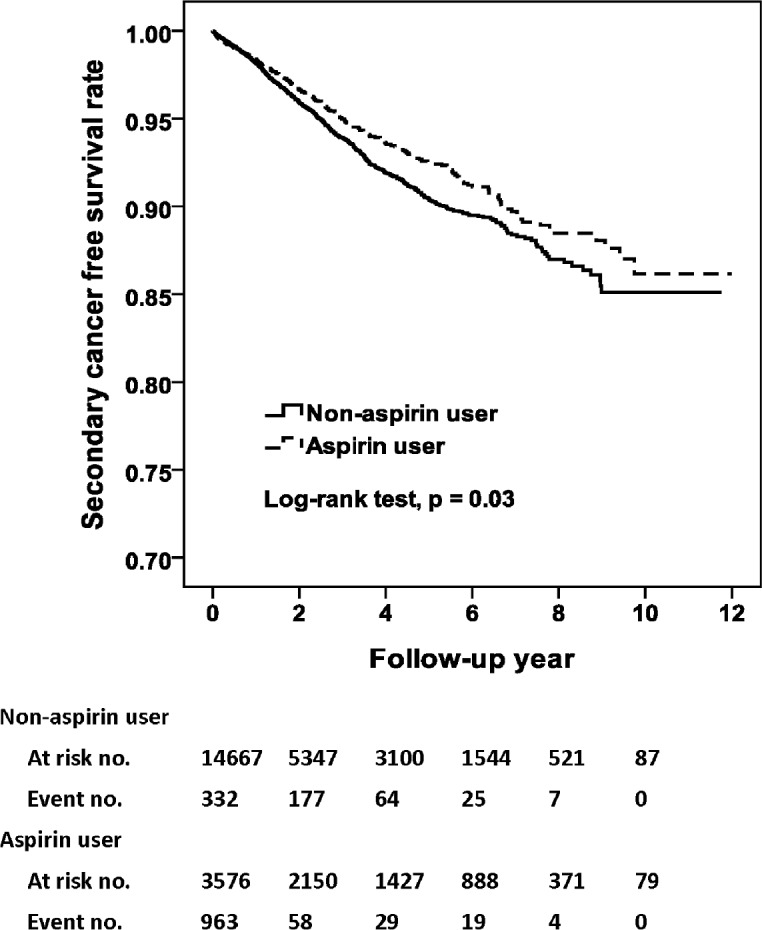
Secondary cancer free survival rates for primary HNSCC cohort with and without Aspirin intake.